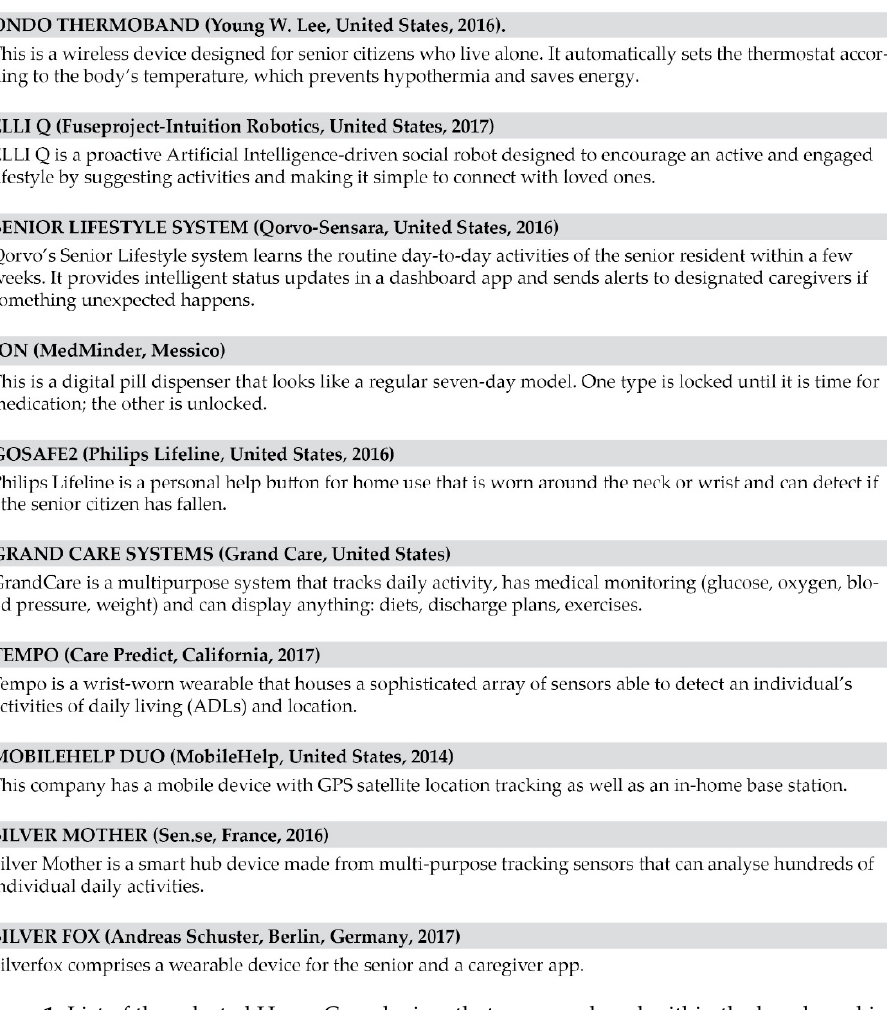
Figure 1. List of the selected Home Care devices that were analyzed within the benchmarking.